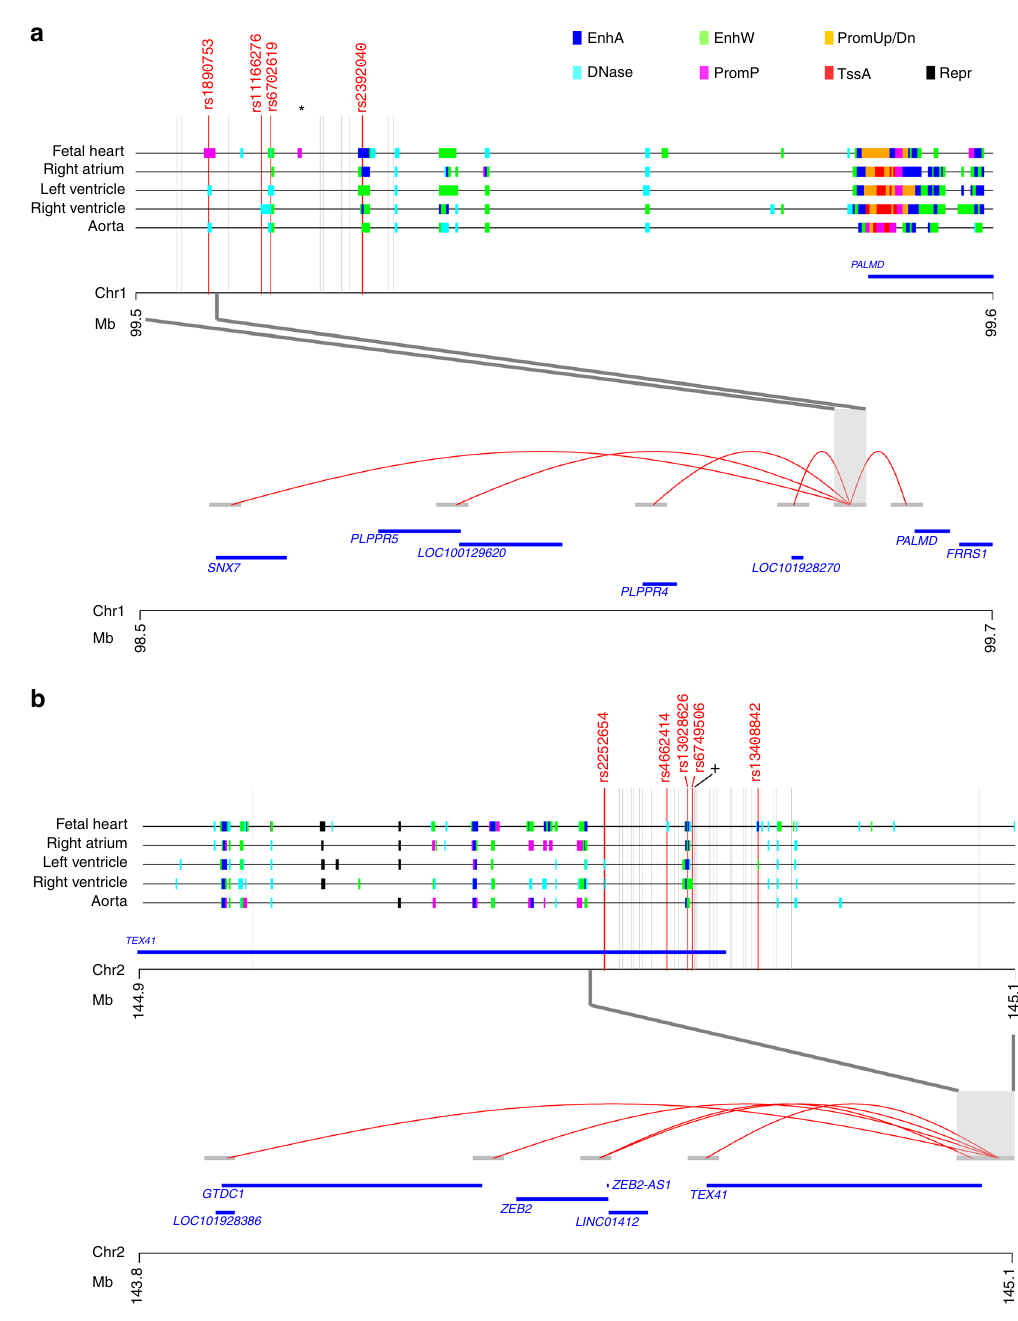
Fig. 1 Chromatin interactions between regulatory regions harboring candidate causal variants at the PALMD and TEX41 loci. Chromatin states indicative of regulatory regions for the aortic valve stenosis locus on chromosomes 1p21 ( a ) and 2q22 ( b ) are shown for heart and aorta tissue samples. Different types of regulatory states are indicated with distinct colors shown at the top of the fi gure. EnhA (Enhancer Active), EnhW (Enhancer Weak), PromUp/Dn (Chromatin marks characteristic of a promoter region found upstream or downstream of TSS), DNase (DNase, nucleosome-free/open chromatin region), PromP (Promoter poised region, marked simultaneously as active and repressed, poised for activation during development), TssA (Transcription Start Site, Activated), and Repr (Repressive marks, heterochromatin). Vertical gray lines indicate the variants found in LD ( R 2 > 0.50) with a rs7543130 (*) ( N = 19) or b rs1830321 ( + ) ( N = 50). Variants found to overlap with regulatory regions in any of the fi ve tissues are marked up and indicated as red vertical lines. Long-range chromatin interactions in left ventricle tissue samples are shown for a the region harboring rs1890753 on chromosome 1p21 with red curved lines, including interactions to promoters for PALMD , PLPPR4 , PLPPR5 , DPH5 and SNX7 , LOC100129620 and LOC101928270 , and for b regions